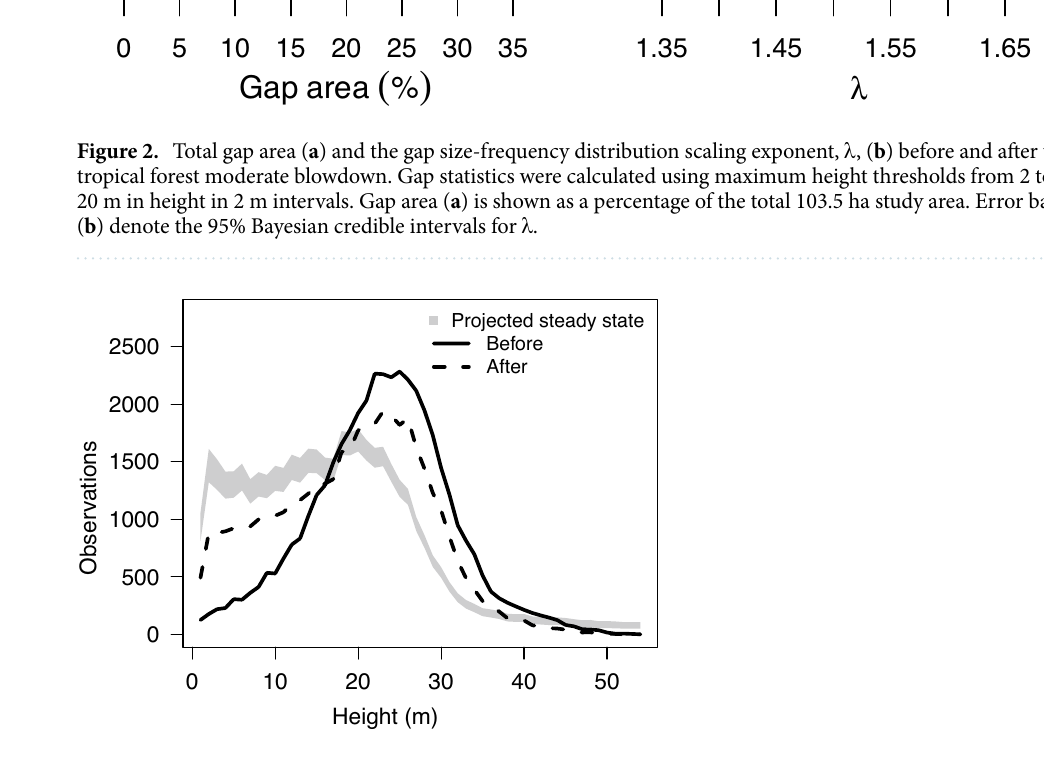
Figure 3. Distributions of canopy height (lines) before and after a moderate blowdown in the Atlantic lowlands of Costa Rica. The shaded region is the posterior of the projected distribution of canopy height based on the dominant right-hand eigenvector of a height transition matrix; the range of values at each height is the 95% Bayesian credible interval for the projected